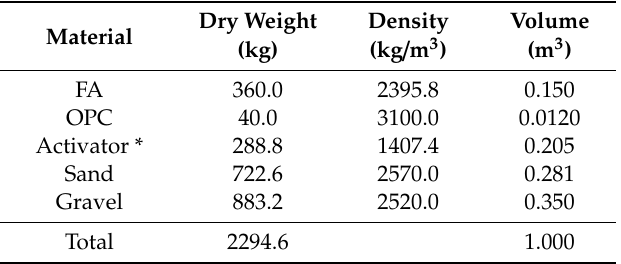
Table 2. Dry dosage per cubic meter of concrete (1 m 3